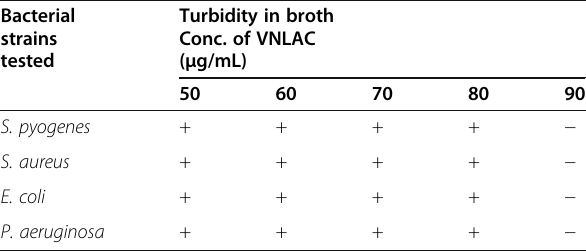
Table 2 Inhibition of bacterial strains using different concentrations of VNLAC in broth after 24 h of incubation at 37 o